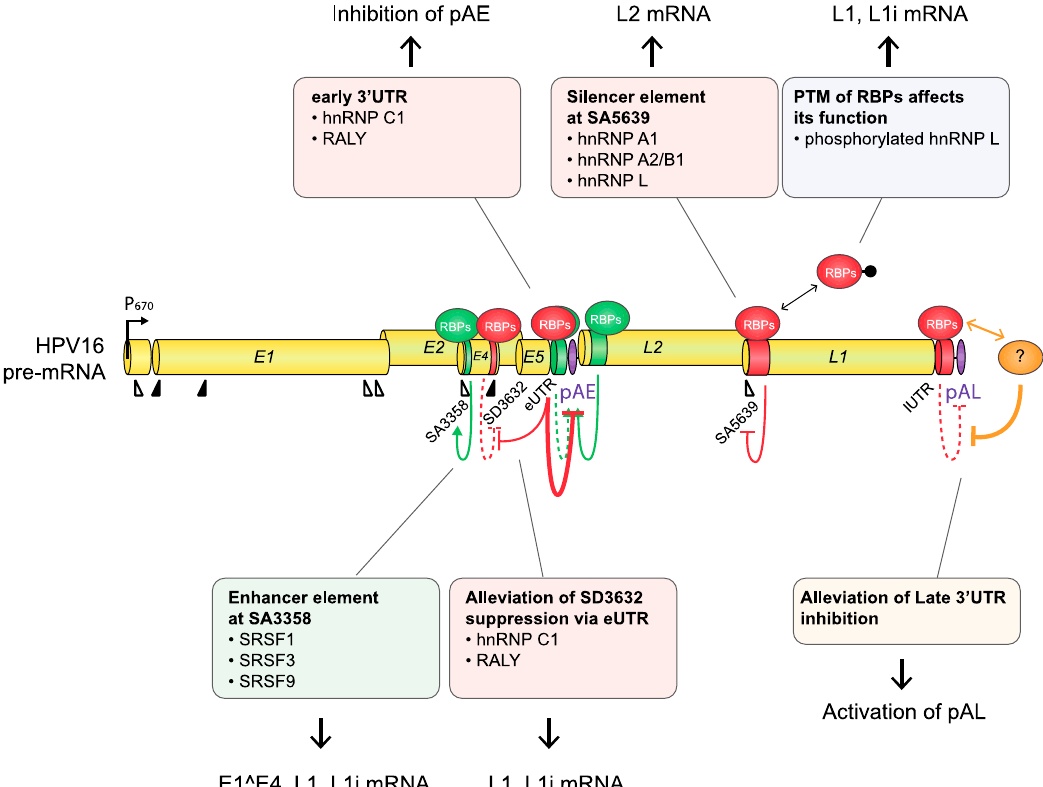
Figure 7. Regulation of HPV16 pre-mRNA splicing and polyadenylation during the HPV16 late life cycle. There are multiple cis-acting regulatory RNA elements on HPV16 late mRNAs, indicated here as green cylinders (splicing enhancers) and red cylinders (splicing silencers), that interact with RNA-binding proteins (RBPs) that either activate (green spheres) or suppress (red spheres) splicing or polyadenylation. Proteins that control HPV16 splice sites SA3358, SD3632, and SA5639 or the HPV16 early and late polyadenylation signals pAE and pAL, respectively, have been identified. Proteins controlling pAE and pAL bind to the early or late untranslated regions, eUTR and lUTR, respectively. Red arrows indicate suppression, and green arrows indicate activation. Dotted lines represent events that must be reversed during switch from early to late gene expression. Proteins that have been identified and shown to control HPV16 splice sites or polyadenylation signals are listed in boxes. See text for more details.